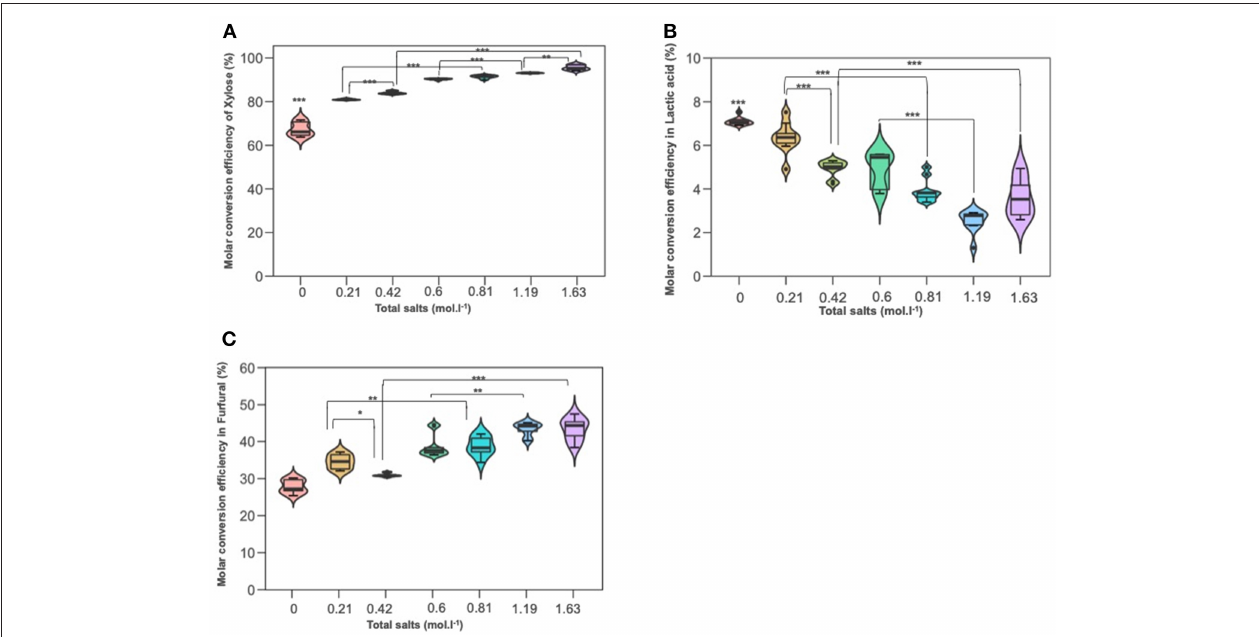
FIGURE 5 | The effect of adding NaCl and KI in hydrothermal dehydration of D-xylose: (A) molar conversion efficiency of D-xylose (B) molar conversion efficiency into lactic acid and (C) molar conversion effeciency into furfural (C) . Molarities 0; 0.21; 0.42; 0.6; 0.81; 1.19; 1.63 corresponding g/L to deionized water 35KI; 70KI; 35NaCl; 35 KI + 35NaCl; 70NaCl; 70KI + 70NaCl, respectively. Significant differences were determinated with on-way ANOVA and Tukey HSD post hoc test (* P < 0.05; ** P < 0.01; *** P < 0.001).